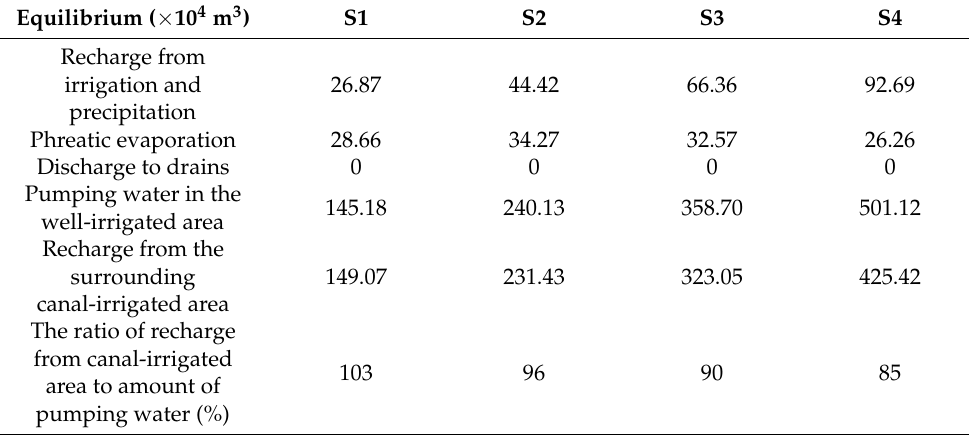
Table 5. Annual average water balance of well-irrigated area of 4 scenarios with different size of single well-irrigated